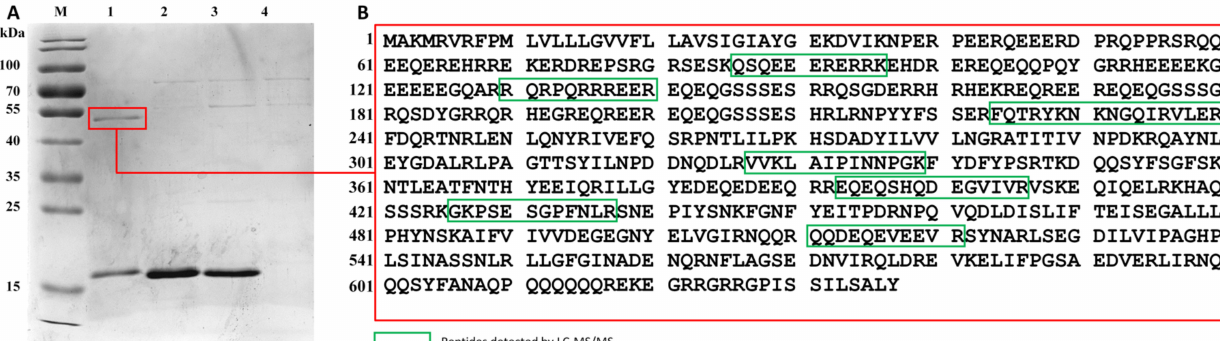
Figure 5. Identification of the target antigen of Nbs after immunocapture and LC-MS/MS. ( A ). The immunoprecipitate from crude lupine protein extract captured by Nb B187 via magnetic beads. The complex was separated by SDS-PAGE after unfold of di-sulfate bonds. Lane M: Pre-stained protein ladder; Lane 1: Nb B187 incubated with lupine protein extraction and Ni-NTA magnetic beads; Lane 2: Nb B187 incubated with Ni-NTA magnetic beads; Lane 3: an irrelevant Nb B147 (specific to the food-borne pathogen of Staphylococcus aureus (S. aureus)) incubated with lupine protein extraction and Ni-NTA magnetic beads; Lane 4: lupine protein extraction incubated with Ni-NTA magnetic beads. ( B ). Identification of the immunocaptured antigen by LC-MS/MS. The matched peptides from the cleaved bands (55 kDa) are indicated in the red rectangle. The target antigen was identified as Lup an 1 (UniProt sequence accession number: